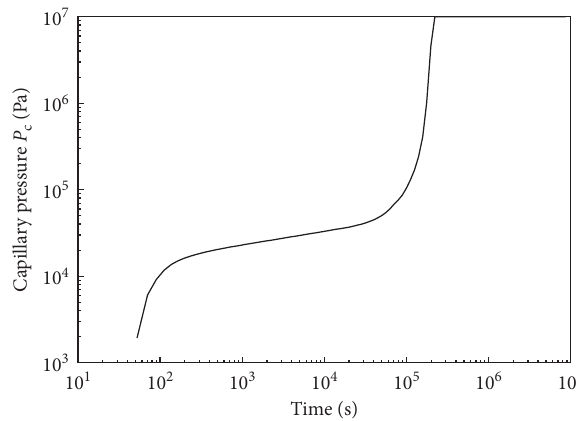
Figure 11: Time evolution of capillary pressure at the observation point.